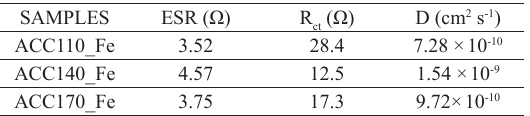
Figure 11. Nyquist plots of ACC110_Fe, ACC140_Fe, and ACC170_Fe. The total equivalent circuit for the plots (inset image). parameters of flexible electrodes obtained Table 4. ESR and R ct from the Nyquist plots and diffusion coefficients (D) calculated by Equation